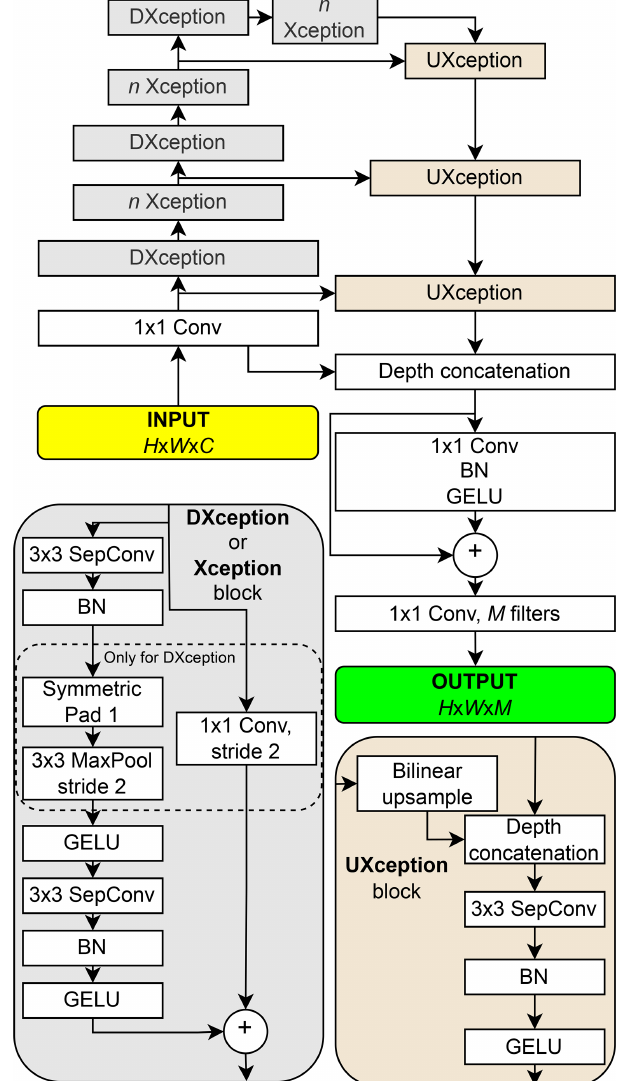
Figure 4. The CNN architecture used, for an input image of spa- tial size H × W pixels and C channels, producing an output of the same dimensions with M channels. Here M = 99, corresponding to all percentiles. Block widths relate to the spatial sizes at each stage (not to scale). In each convolutional layer 128 filters were used, and n Xception means that n consecutive Xception blocks are applied, where it was chosen n = 2. Depthwise separable convolutions (Sep- Conv), with a 3 × 3 kernel, preserve the spatial size using a replicate padding of 1 at the depthwise convolution. GELU: Gaussian error linear unit (Hendrycks and Gimpel, 2020), BN: batch normaliza- tion (Ioffe and Szegedy, 2015), 1 × 1 Conv: pointwise convolution. Strides of 1, otherwise